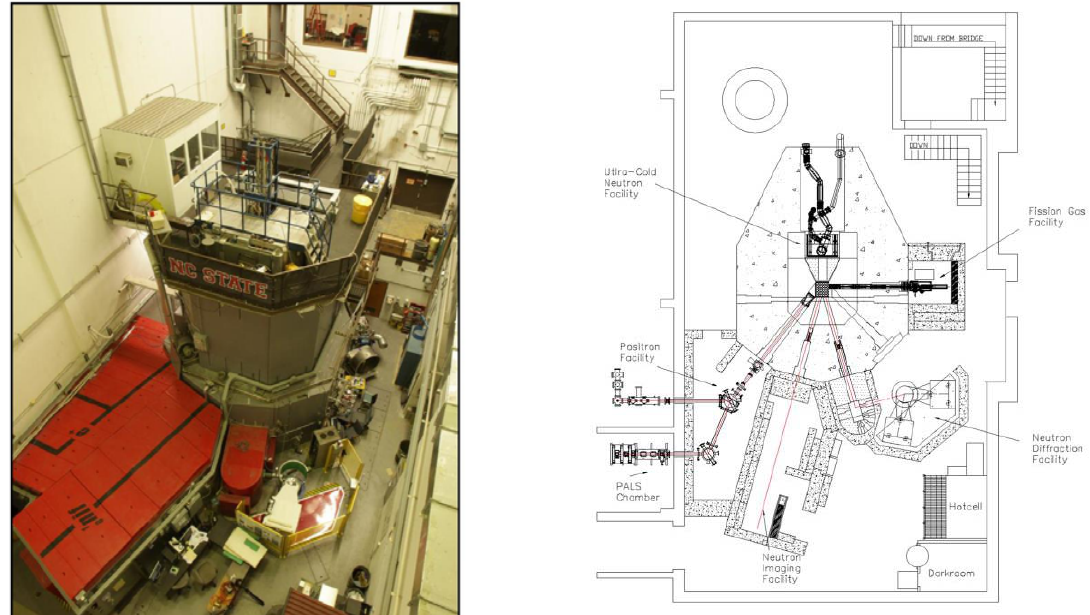
Fig. 2. A view of the PULSTAR reactor’s bay floor (left). The corresponding layout of the bay floor showing the various facilities on each beam